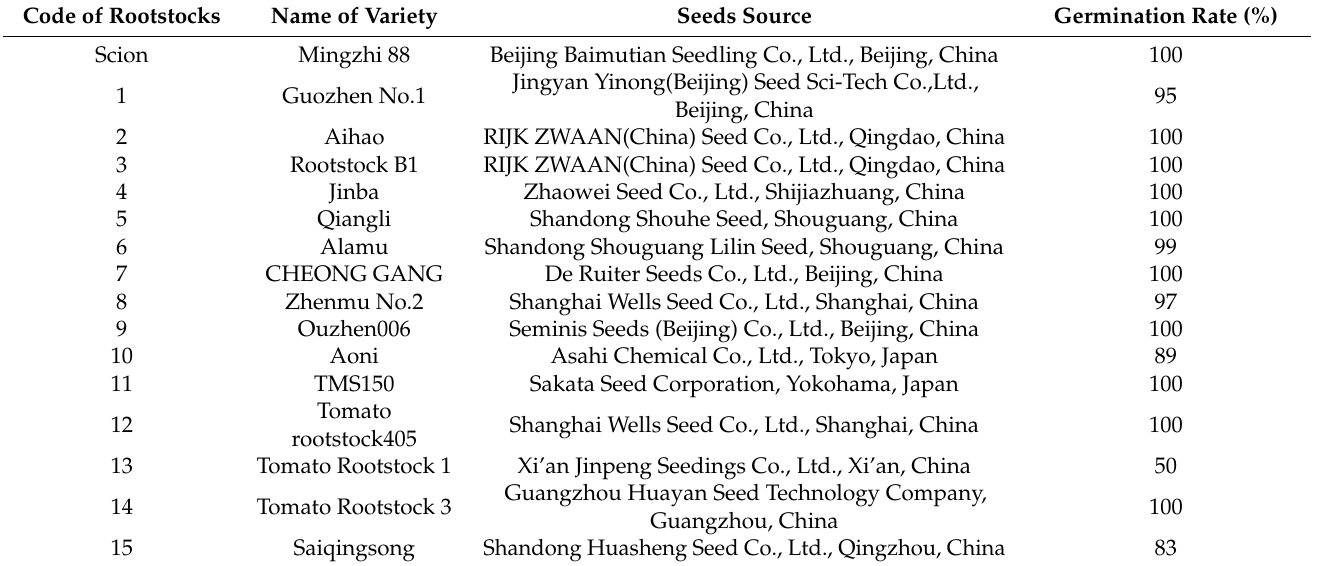
Table 1. Sources of tomato rootstocks and scion